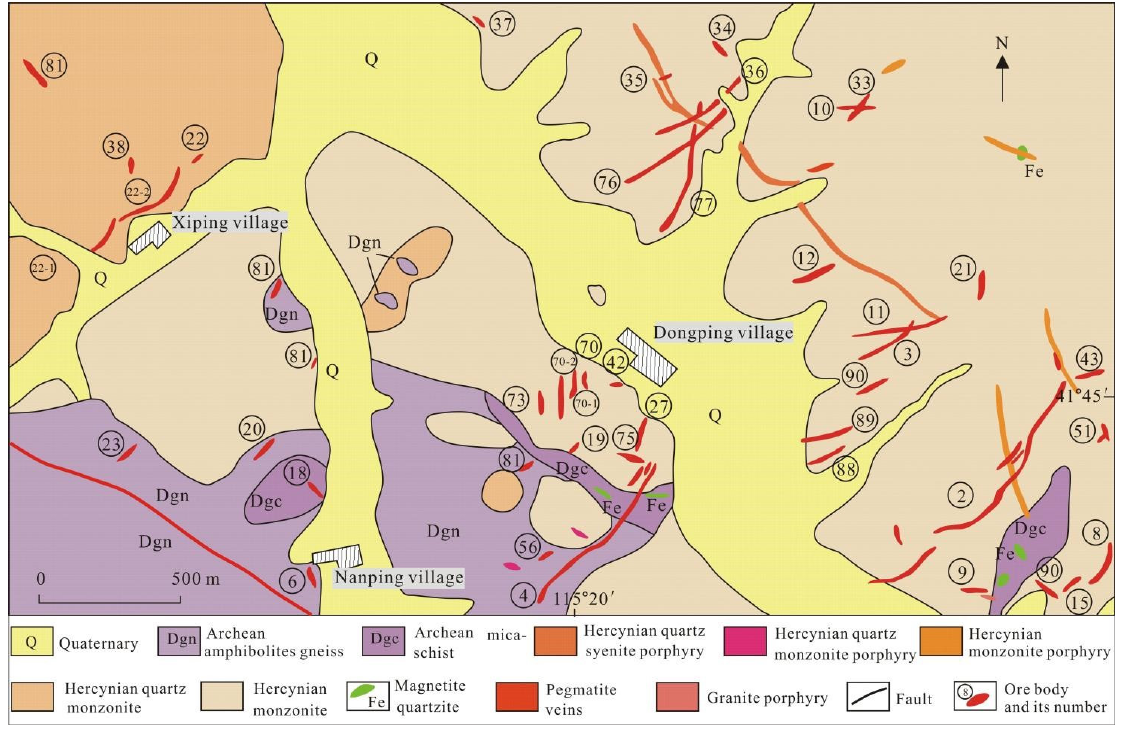
Figure 3. Simplified geological map of the Dongping gold deposit (modified after Wang et al.